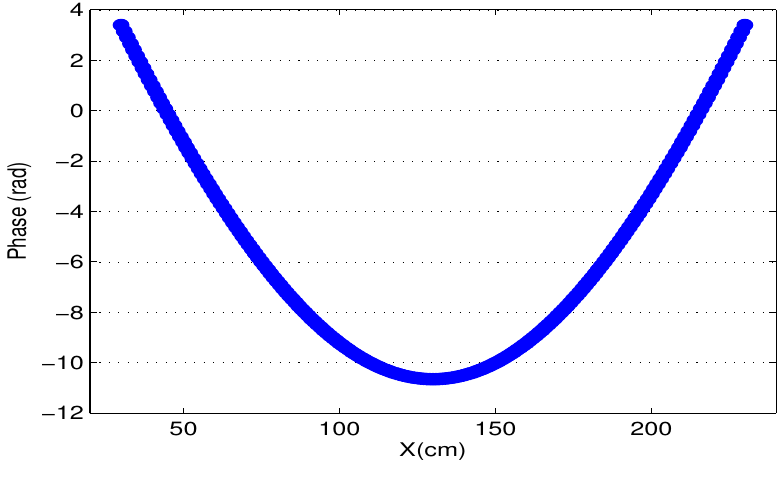
Figure 6. The unwrapped phase